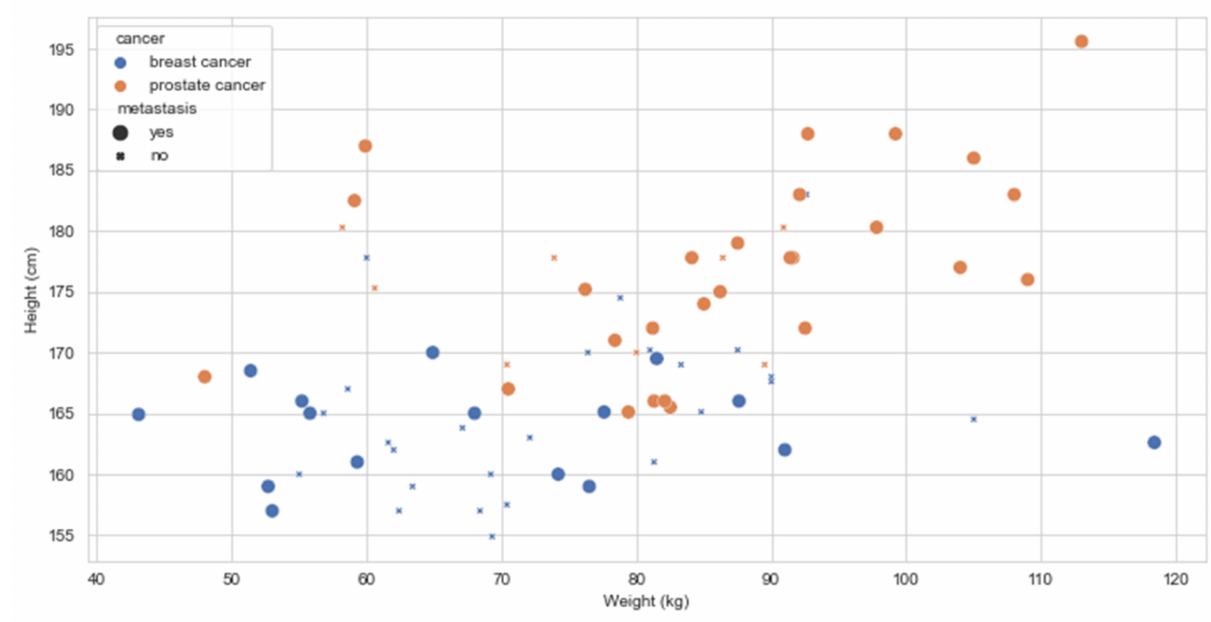
Figure 4. Population graphs for BCa and PCa BMI for metastatic and non-metastatic disease.